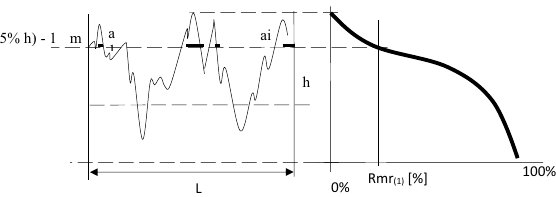
Fig. 2 Roughness profile and reference system